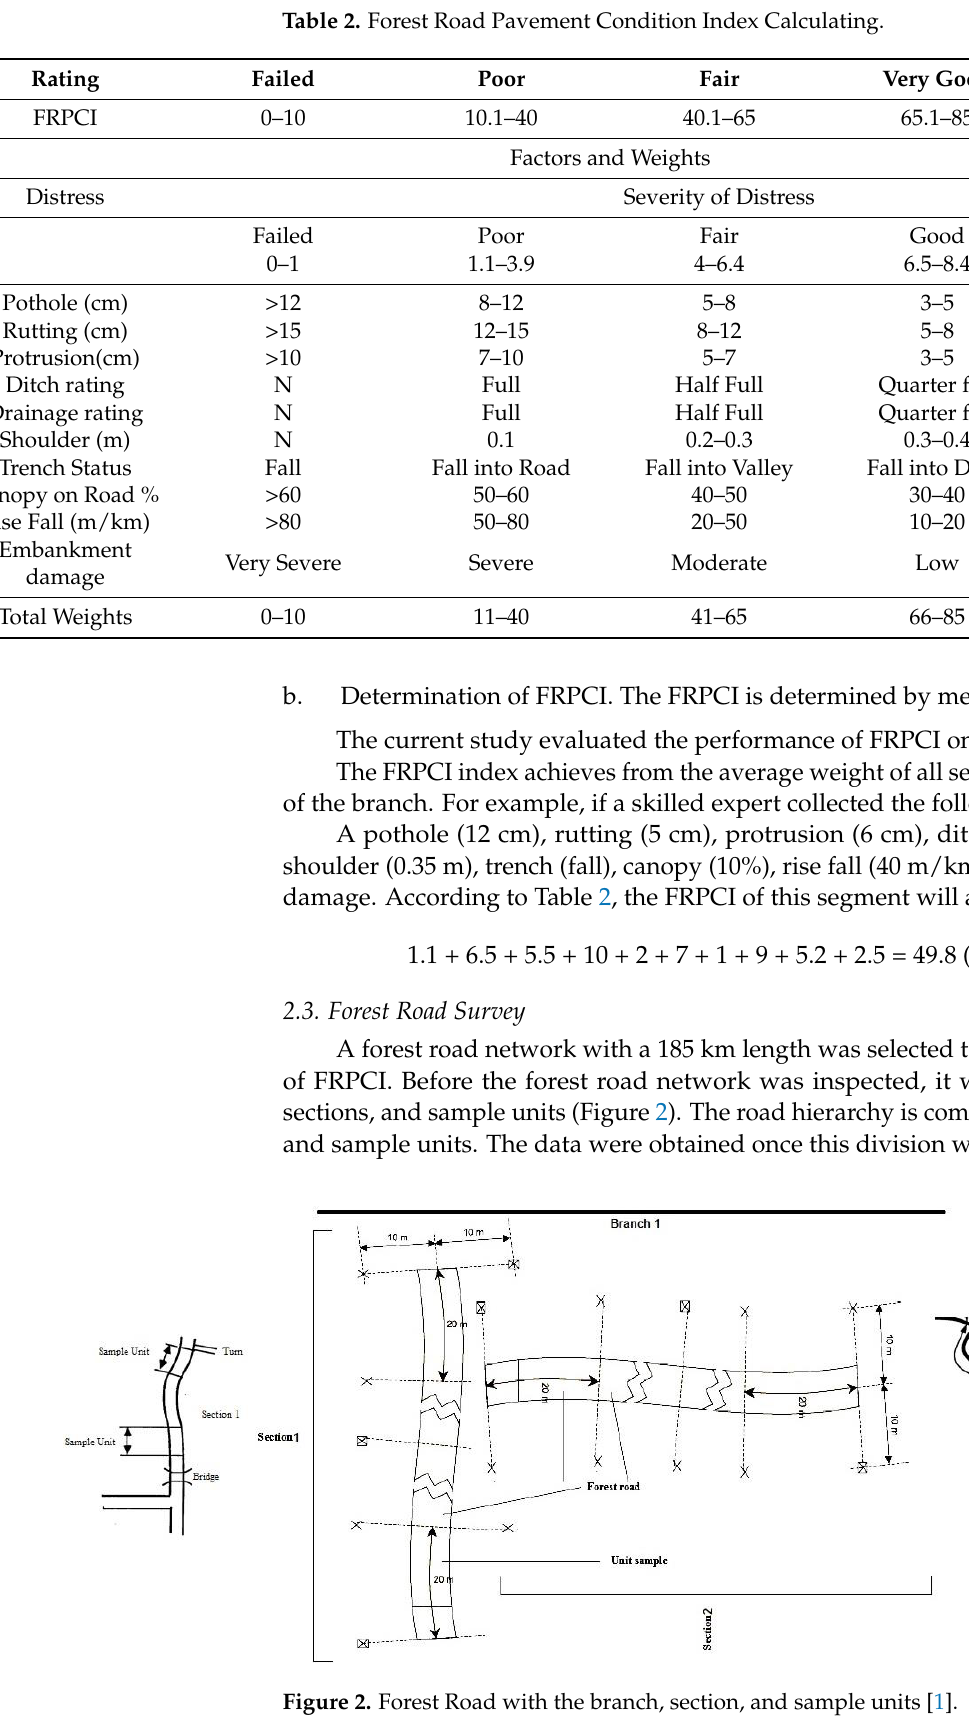
Figure 2. Forest Road with the branch, section, and sample units